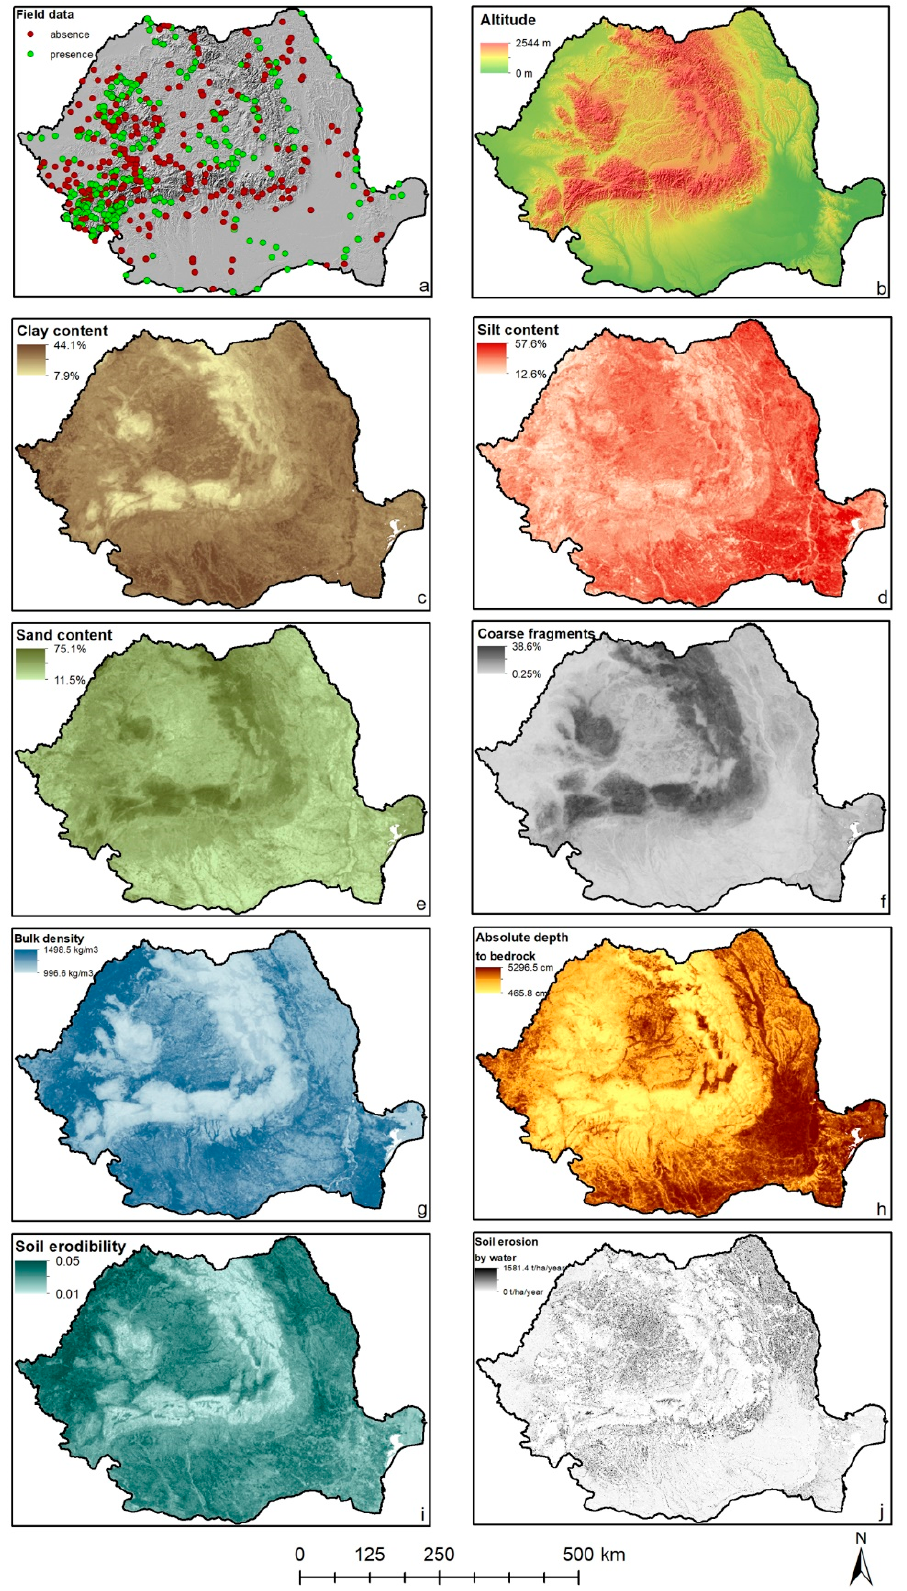
Figure 1. ( a ) Maps showing sampling points coverage (presence/absence) across the territory of Romania; ( b ) altitude of the investigated area; ( c – e ) soil clay, silt, and sand content; ( f ) soil coarse fragments content; ( g ) soil bulk density; ( h ) absolute depth to bedrock; ( i ) soil erodibility; ( j ) soil erosion by water.